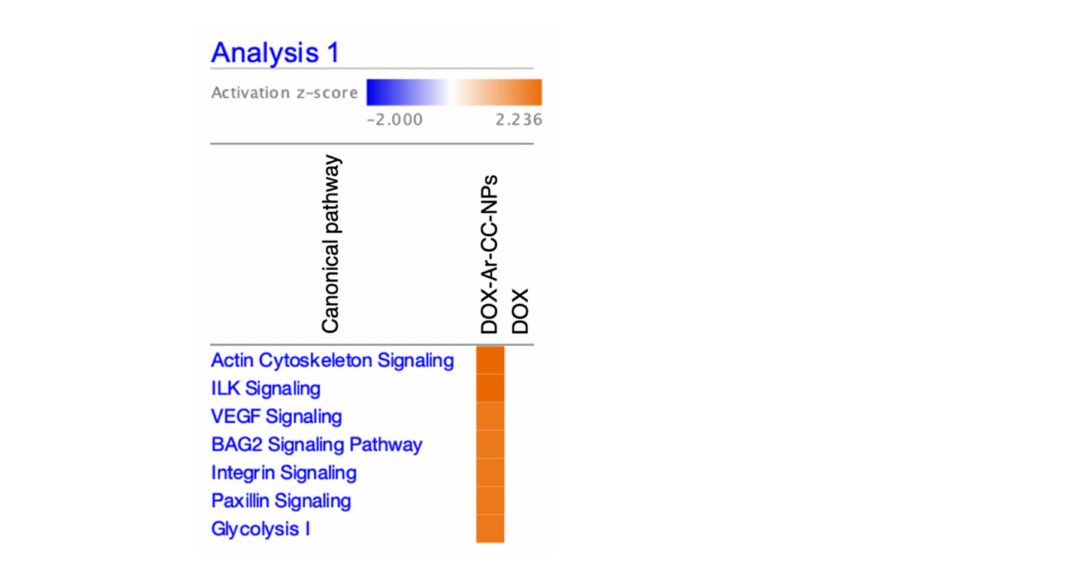
Figure 8. Heat map generated from the IPA comparison analysis showing the top 7 canonical pathways affected by changes of proteins in response to the treatments of DOX-Ar-CC-NPs compared to DOX. Orange and blue bars indicate positive and negative activation z-scores, respectively, while transparent bar indicates no activation. Table 4. IPA analysis. A summary of IPA comparison analysis showed the top predicted canonical pathways affected by changes of proteins in response to the treatments of DOX-Ar-CC-NPs compared to DOX. Top Canonical Pathway Actin cytoskeleton